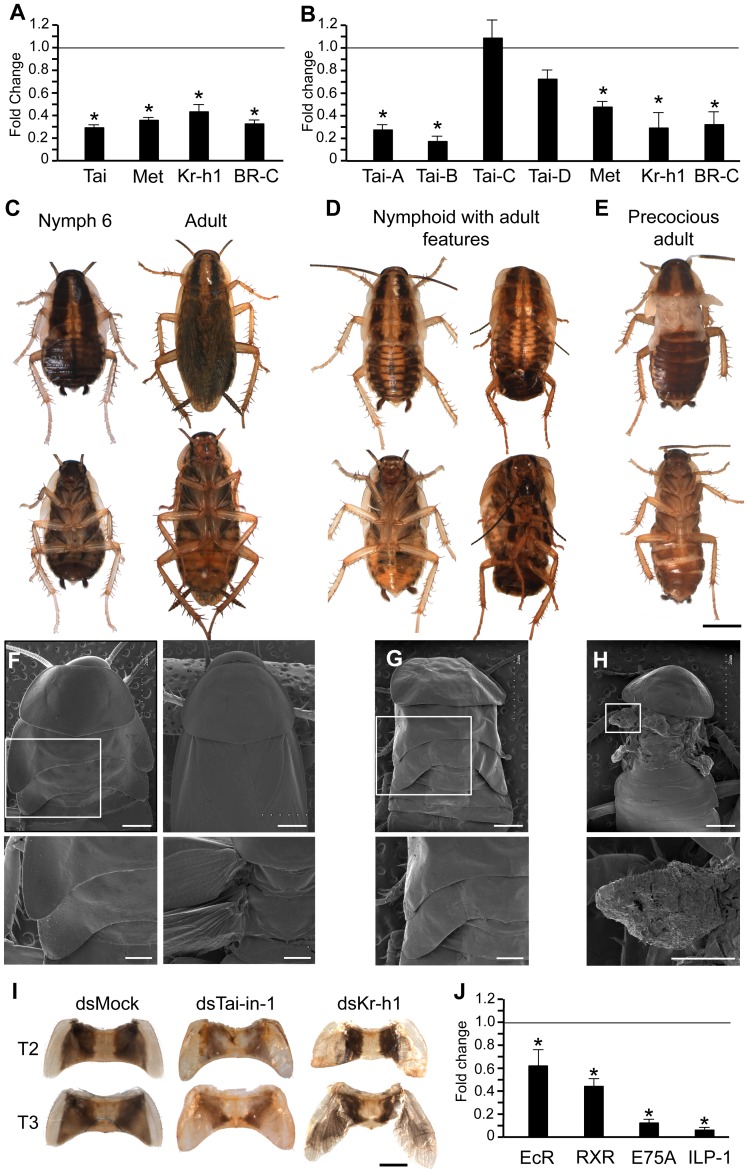
Function of BgTai in Blattella germanica metamorphosis.(A) Effects, at transcript level, of dsTai-core treatment in N5; N5 females received two 3-µg doses of dsTai-core, one on N5D0 and the other on N5D3, and transcript levels (of Tai, Met, Kr-h1 and BR-C) were measured on N5D6; controls received an equivalent treatment with dsMock. (B) Effects, at transcript level, of dsTai-in-1 treatment in N4; the experimental design was equivalent to that used in N5, with a double treatment, one on N4D0 and the other on N4D3; transcript levels (of Tai-A, Tai-B, Tai-C, Tai-D, Met, Kr-h1 and BR-C) were measured on N5D6. (C–E) Dorsal and ventral view of specimens resulting from dsTai-in-1 treatment in N4; normal last nymphal instar and adult obtained from dsMock treatments (C); nymphoids with adult features obtained (instead of N6) from dsTai-in-1 treatments (D); precocious adult obtained (instead of N6) from dsTai-in-1 treatments (E). (F–H) SEM images of T2 and T3 (general and detail of the lateral parts) from specimens resulting from dsTai-in-1 treatment in N4; normal last nymphal instar and adult obtained from dsMock treatments (F); nymphoid of the figure D, right (G); precocious adult from the figure E (H). (I) Dissected T2 and T3 of: N6 control (dsMock-treated), a nymphoid with adult features obtained after dsTai-in-1 treatment, a nymphoid with adult features obtained after dsKr-h1 treatment. (J) Effects of dsTai-in-1 treatment on N4 on the expression of EcR, RXR, E75A and ILP-1 measured on N5D6. Each point of quantitative data in histograms A, B and J represents 4 biological replicates and results are expressed as the mean ± SEM; data are normalized against the dsMock-treated samples (reference value = 1), and the asterisk indicates statistically significant differences with respect to controls (p<0.05), according to the REST software tool [38]. Scale bars in C, D, E = 3 mm, in F, G, H = upper and bottom respectively = 1 and = 0.5 mm, and in I = 1 mm.